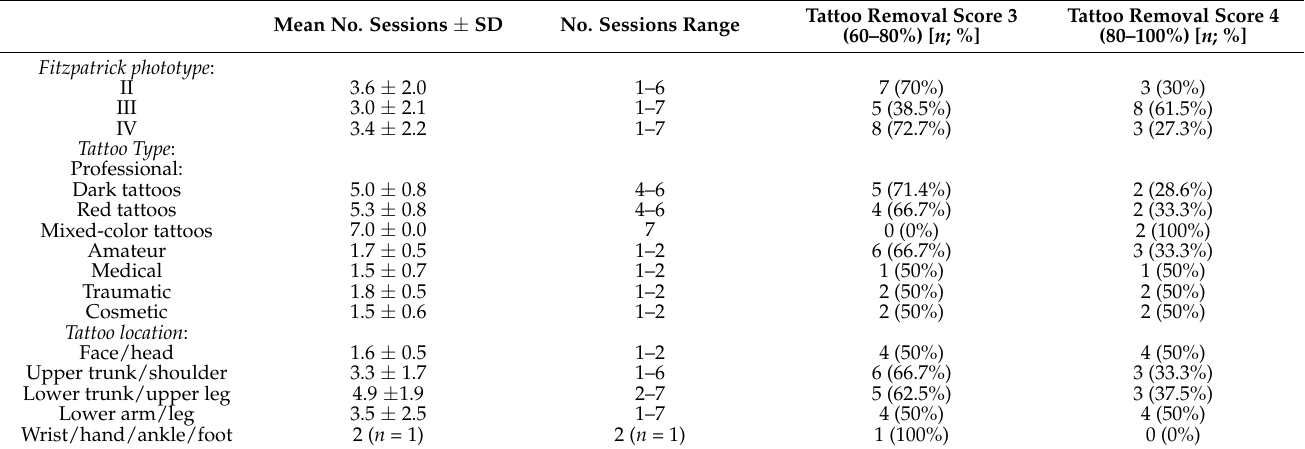
Table 4. Tattoo removal scores and clinical characteristics among different subgroups.